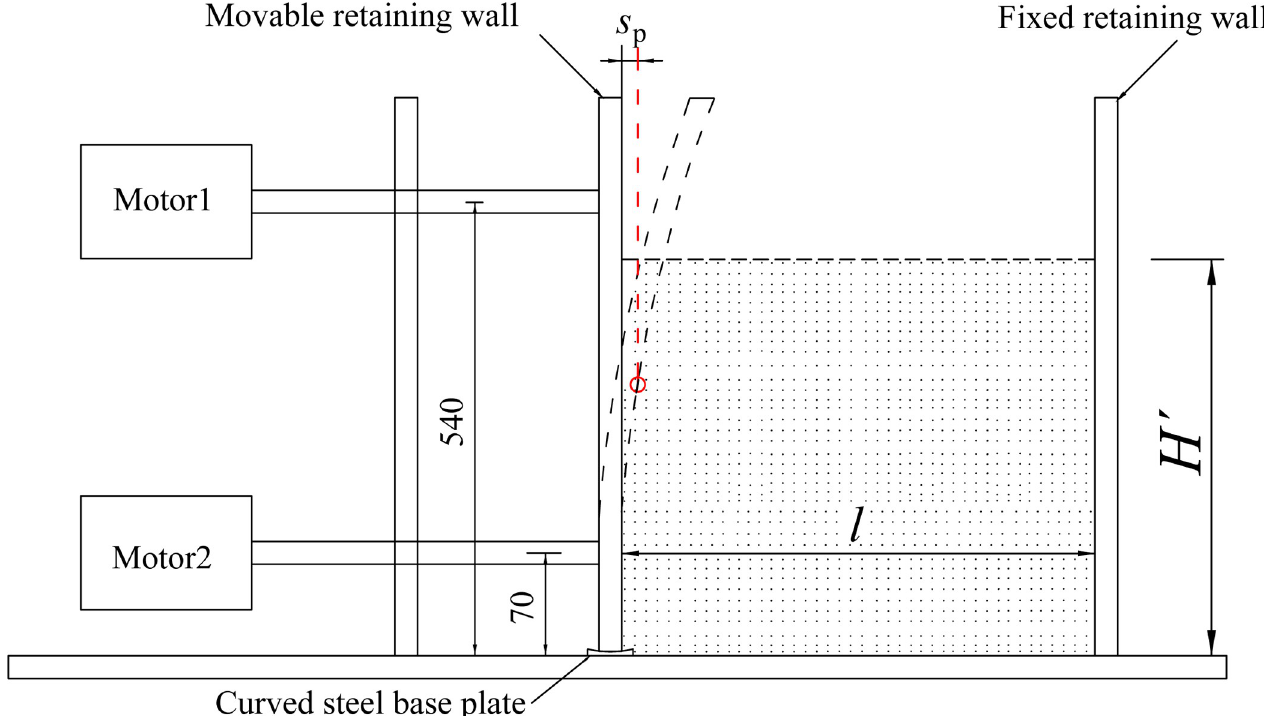
Fig 2. Deformation mode of flexible cantilever